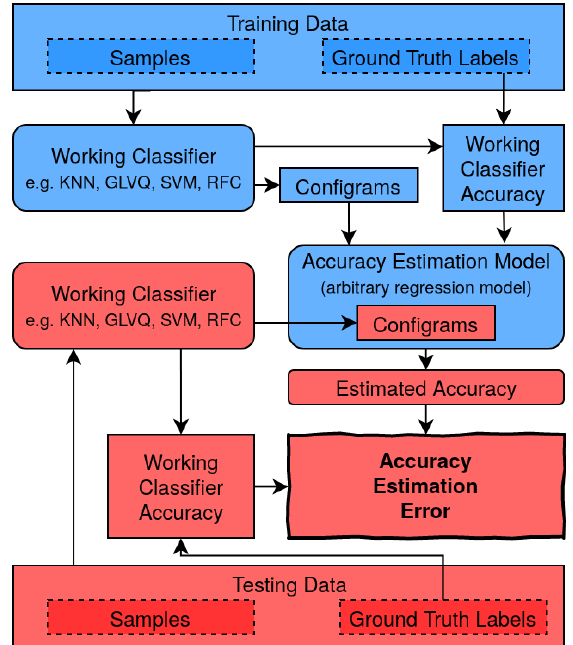
Figure 1. Illustration of accuracy estimation. The accuracy estimation model is trained to predict the working classifier accuracy (computed from ground-truth samples) based on confidence histograms (configrams) of the classifier on unlabeled